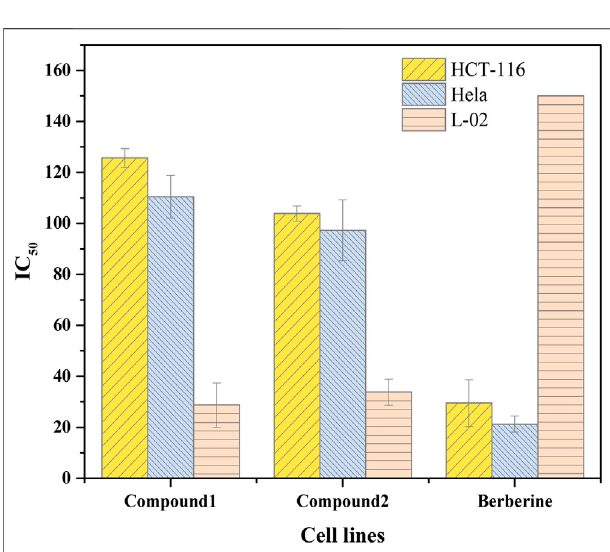
FIGURE 4 | Cytotoxicity analysis of BDP-1 and BDP-2 with the drug berberine as